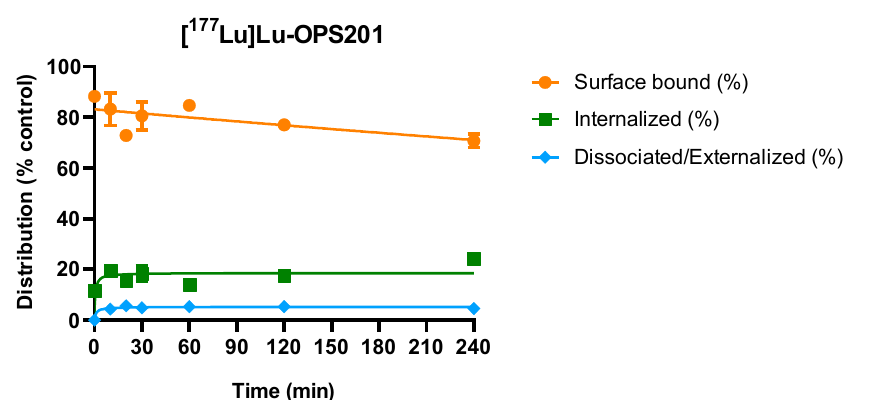
Figure 4. Redistribution of the cell surface ‐ associated [ 177 Lu]Lu ‐ OPS201 at 37 °C, after allowing cell binding for 2 h at 4 °C. Each time point is the average of triplicate wells corrected for non ‐ specific binding.